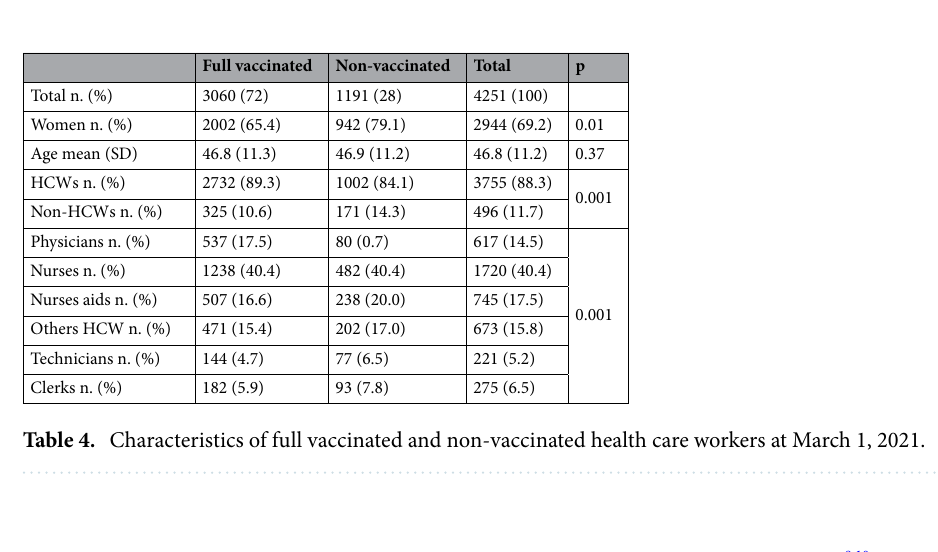
Full vaccinated Non-vaccinated